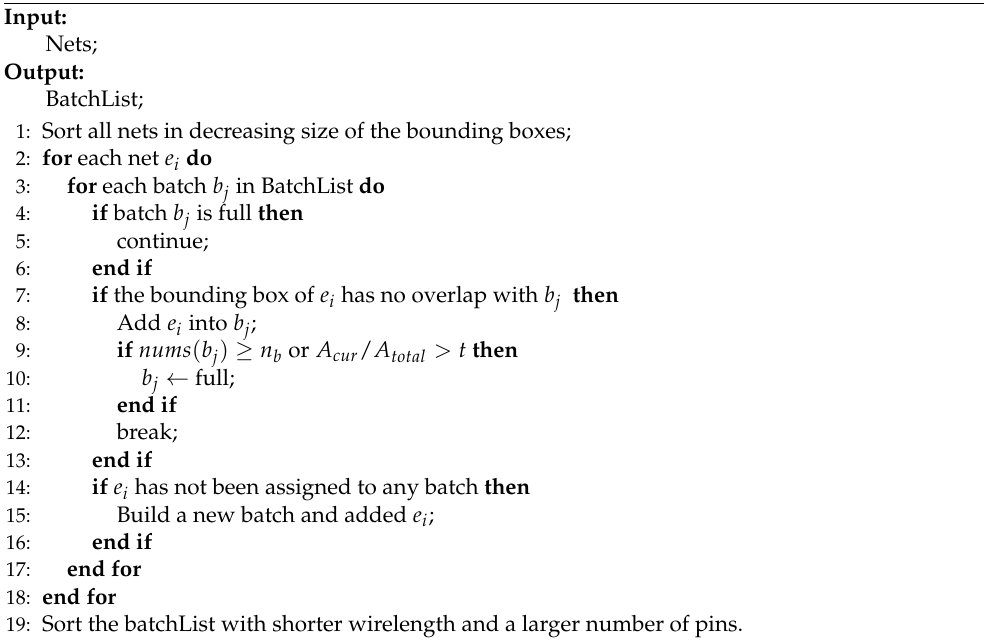
Algorithm 1 Improved Scheduling for Parallel